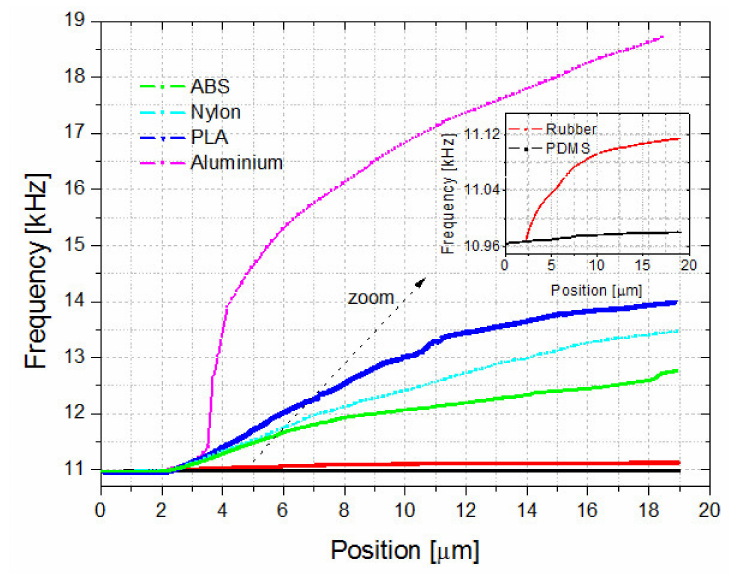
Figure 6. Closed-loop frequency measurements for the PZT-1 actuator.